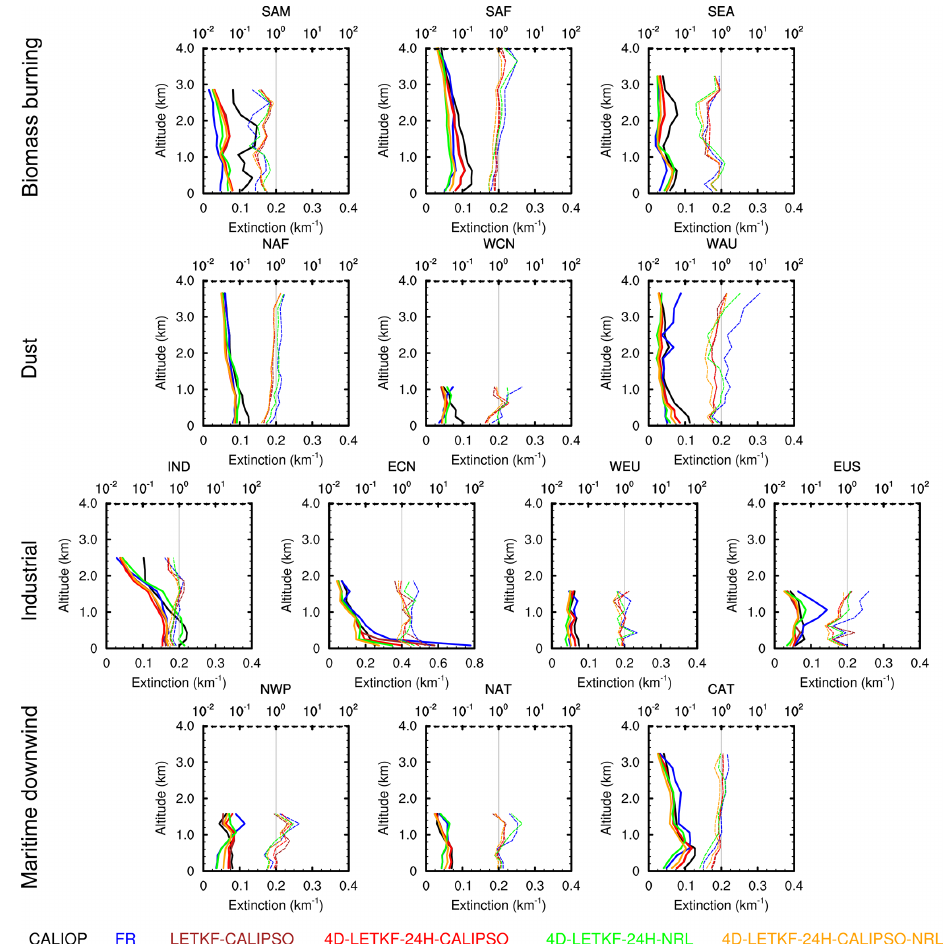
Figure 7. Regionally averaged monthly mean vertical profiles of the simulated aerosol extinction coefficients for the five experiments at 550nm (km − 1 ) and the CALIOP-observed ones at 532nm (solid lines), with the ratios between the simulated and observed standard devia- tions (dashed line) over the 13 selected regions during November